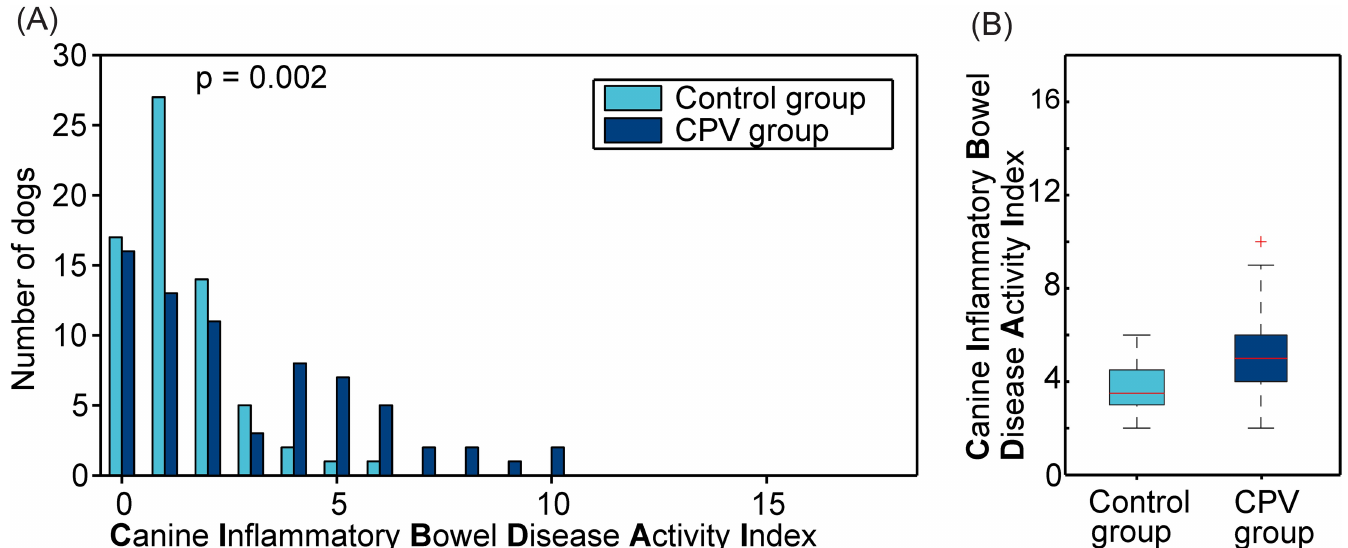
Fig 1. Panel A shows the distribution of the disease activity index CIBDAI (parameters activity, appetite, vomiting, stool consistency, stool frequency, and weight loss) of dogs of the CPV group (n = 71) and dogs of the control group (n = 67) referring to the episodes with the most severe signs of the chronic gastrointestinal disorder. Disease classification: 0–3: clinically insignificant disease, 4–5: mild IBD, 6–8: moderate IBD, > 9: severe IBD Panel B shows the comparison of both groups using a Box- Whisker-Plot.